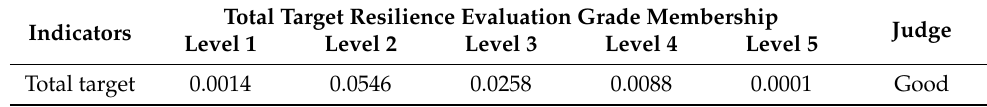
Table 10. Membership degree of overall objective resilience evaluation